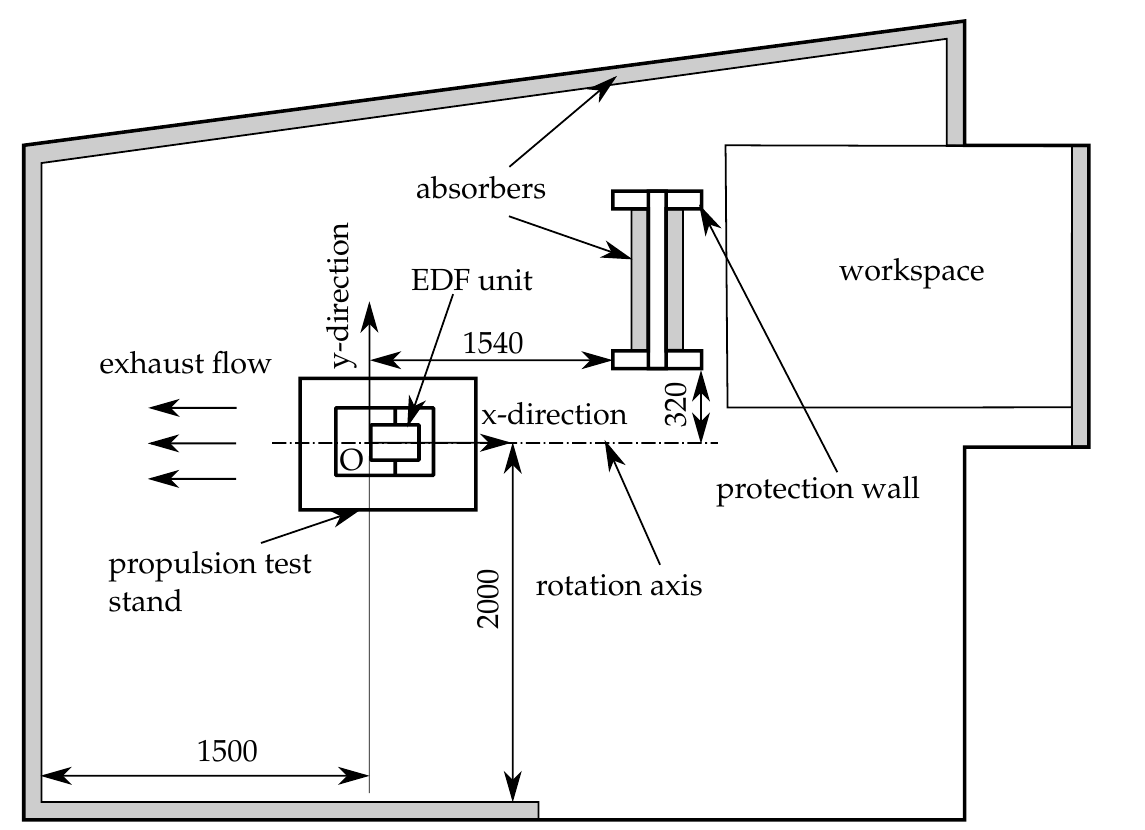
Figure 5. Setup and spatial dimensions of the experimental facility and positioning of the EDF unit on a propulsion test bench inside the measuring room. Adapted from [5].